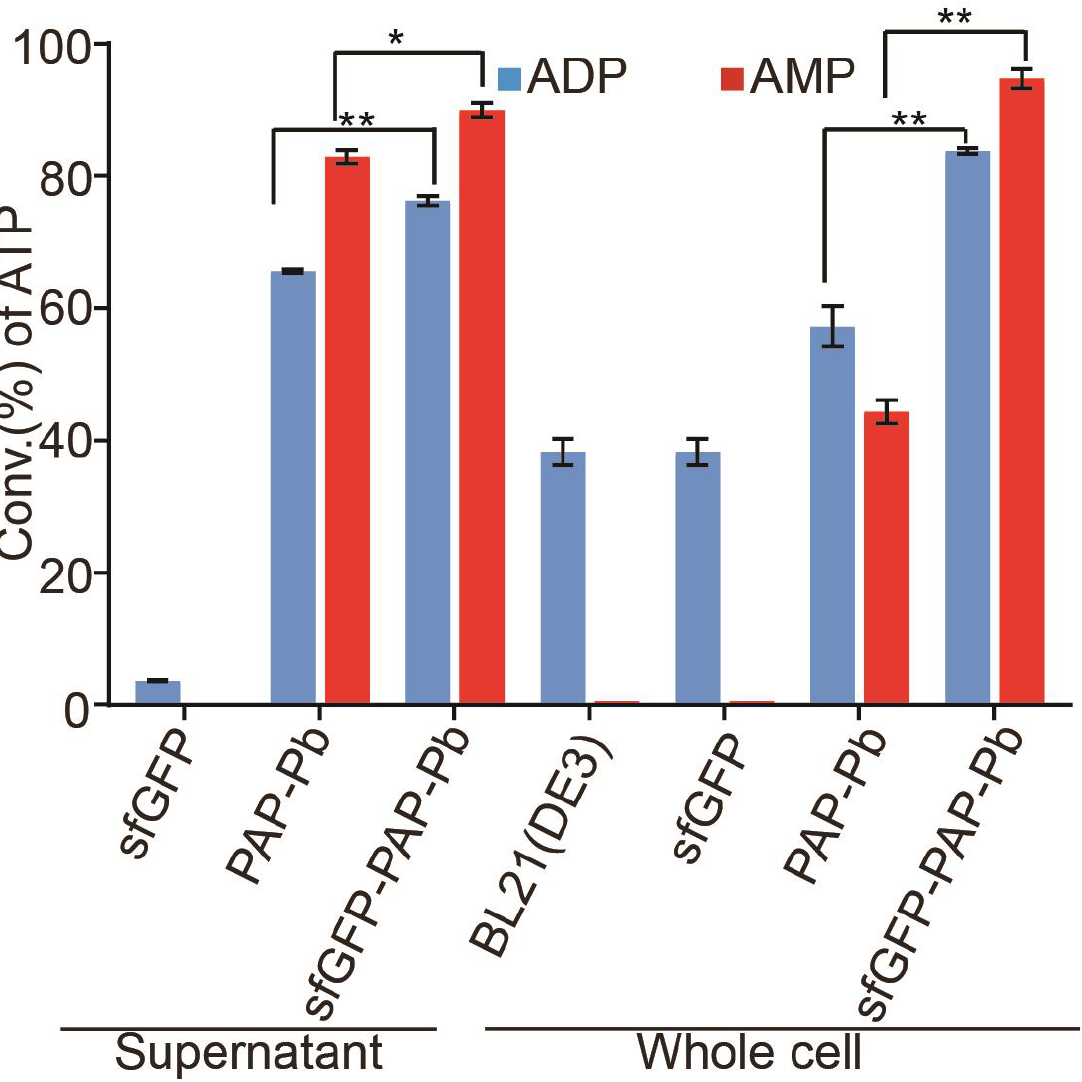
Figure 4. Analysis of ATP conversation with crude enzyme and intact cells. The reaction mixture contains 20 mM poly(P), 4 mM ADP or AMP, 30 mM Mg 2+ , and 50 mM Tris−HCl buffer (pH 8.5). The total volume was brought up to 1000 μL with double -distilled water. Different enzymes or cells were added as shown, sfGFP and BL21(DE3) were as negative controls. The reaction solution was incubated at 37 ℃ for 20 min. A small amount of reaction solution was terminated in 80 °C water bath for 10 min and diluted five-fold for HPLC analysis. Results are means ± SD of three parallel replicates (* p < 0.05, ** p <